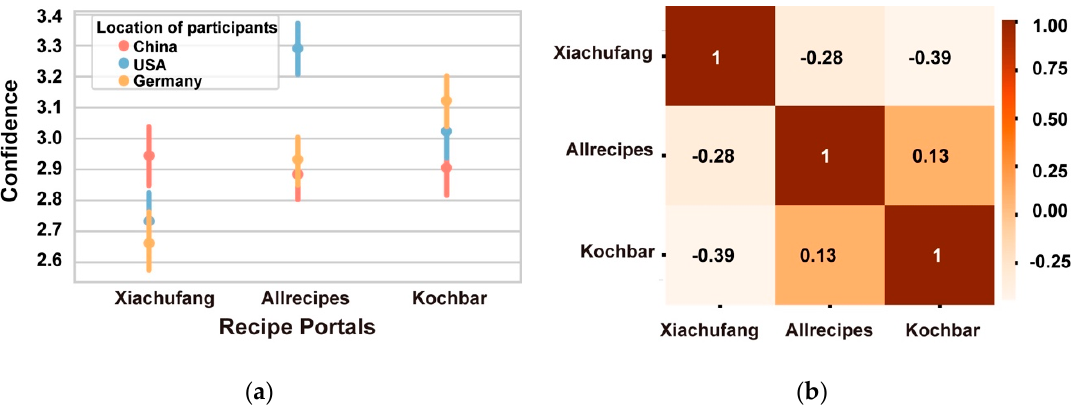
Figure 6. Participant confidence in labels across recipe portals. ( a ) Mean value and error bar for confidence ratings for each collection by participants from di ff erent locations. ( b ) Correlation matrix for participant confidence scores for their labels for di ff erent recipe portals.